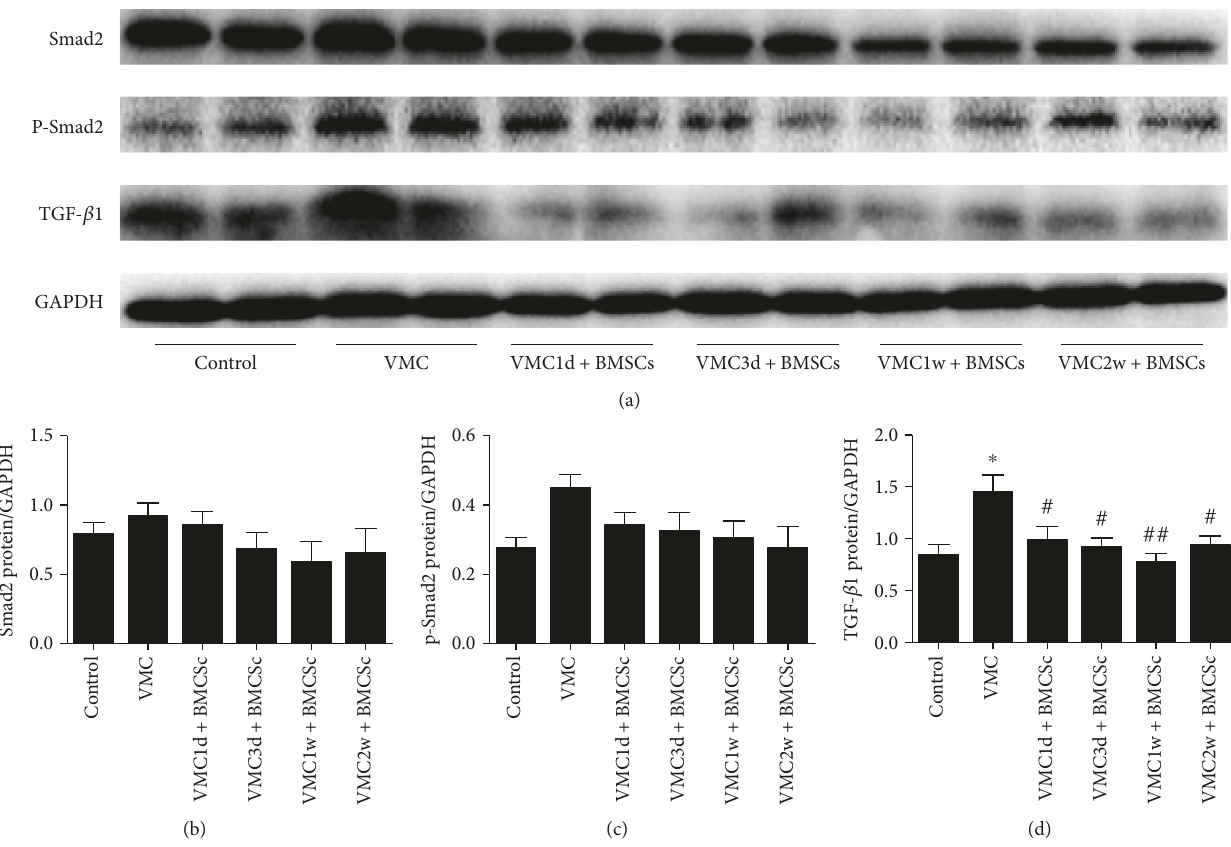
Figure 5: The expression of the TGF- β 1 signaling pathway related to protein in the myocardium with BMSCs treatments. (a) The expression levels of Smad2, p-Smad2, and TGF- β 1 in the myocardium were analyzed by Western blotting. (b – d) Quantitative data of Smad2, p-Smad2, and TGF- β 1 in the myocardium. n = 8 for each group. ∗ P < 0 05 when compared to the control group; # P < 0 05 when compared to the VMC group; and ## P < 0 01 when compared to the VMC